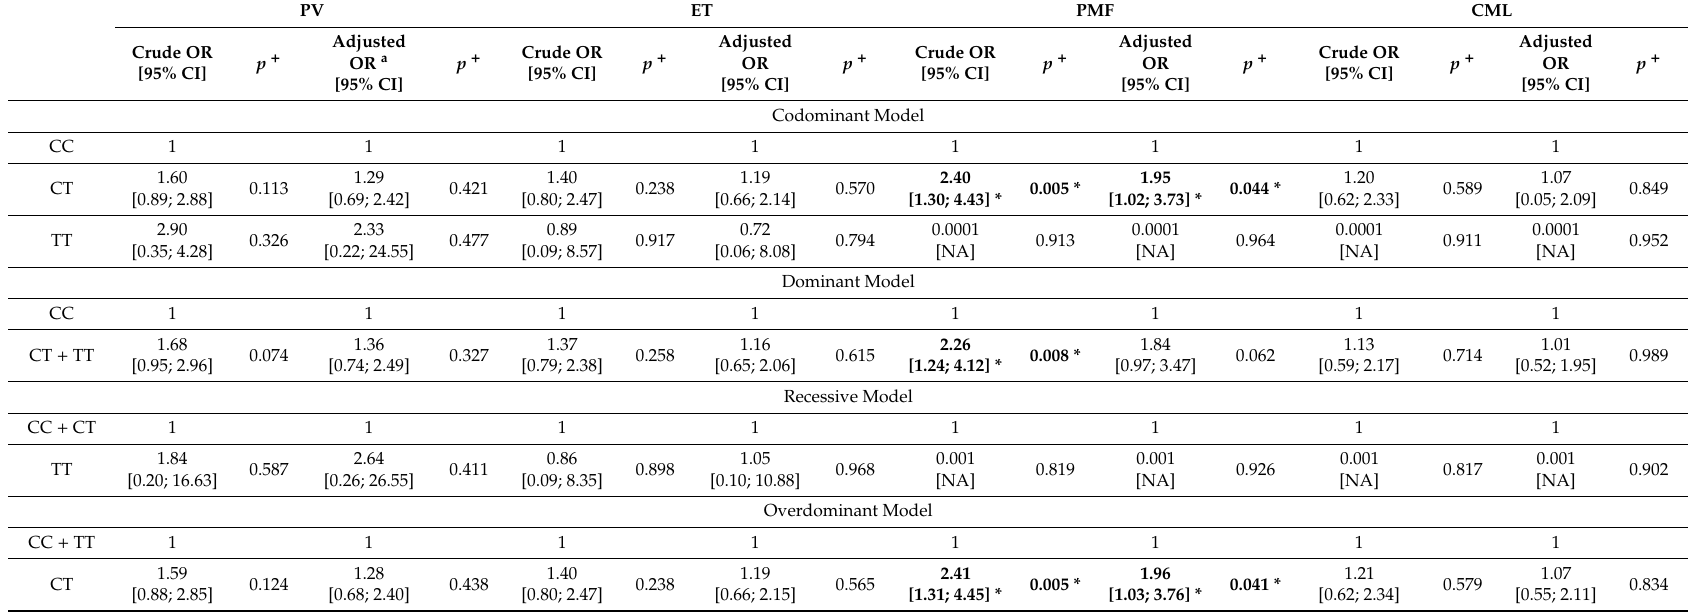
Table 3. Association between TET2 rs154843 SNP and MPN phenotypes: multinomial logistic regression